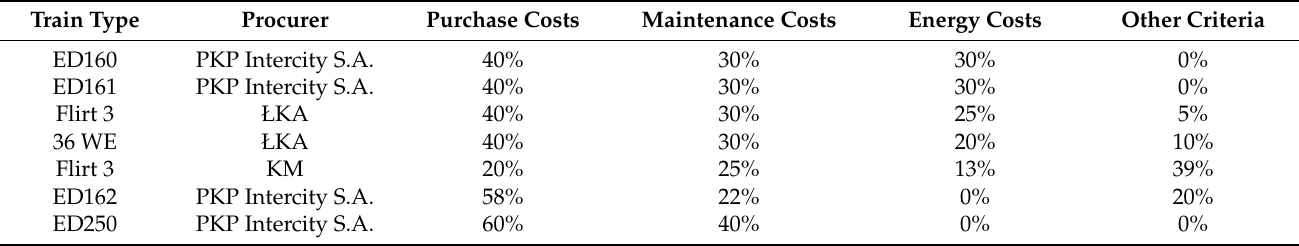
Table 2. Rolling stock evaluation criteria in Polish